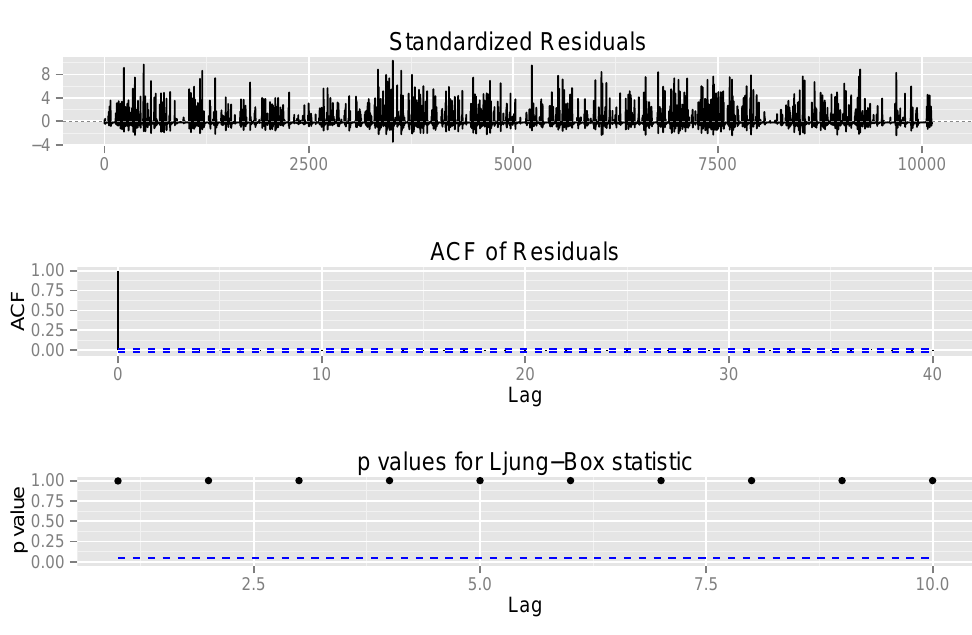
Figure 9. Jump Inter-Arrival Times, Before Tick Size Change.